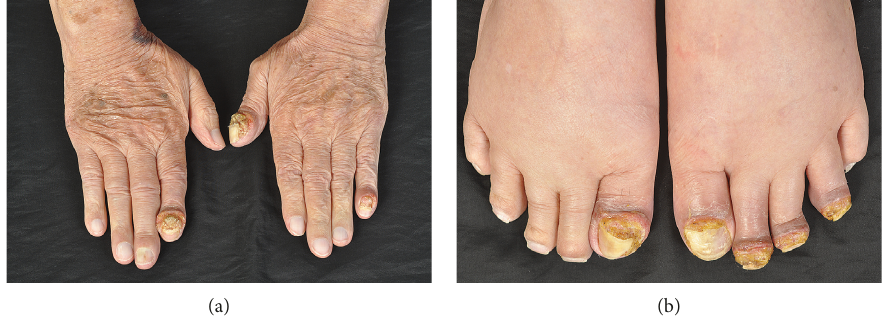
Figure 1: Clinical presentation of a 77-year-old patient with paronychia-like lesions and onychomadesis at tips of fingers and toes.